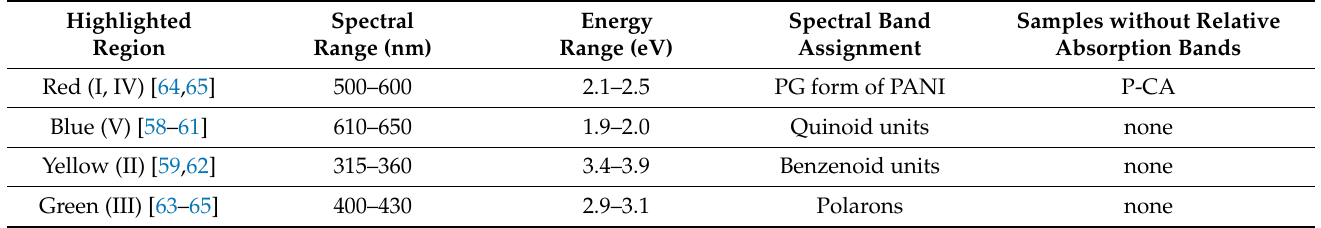
Table 3. Summary of the solid-state UV-Vis absorbance spectra of the PANI and P-CA based on the results shown in the Supplementary Materials (Figure S3).